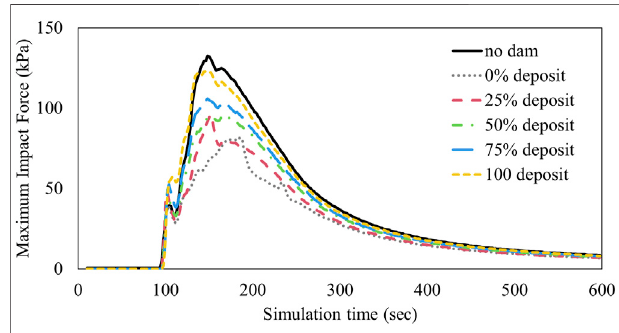
FIGURE 10 | Changes in debris fl ow impact force according to different deposit scenarios.